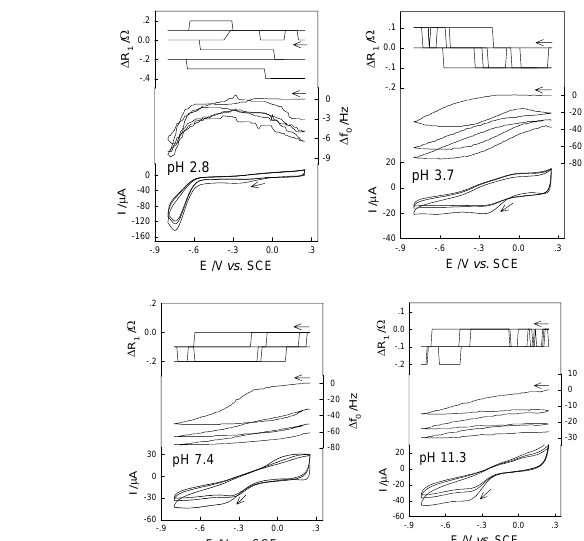
Figure 2 (left) . Simultaneous records of current ( I ), ∆ f 500 Hz PPY/ClO 4- film in 0.1 M HClO 2.0 M NaOH; d E /d t =50 mV/s. Figure 3 (right) . Simultaneous records of current ( I ), ∆ f a 500 Hz PPY/TA film in 0.1 M HClO 2.0 M NaOH; d E /d t =50